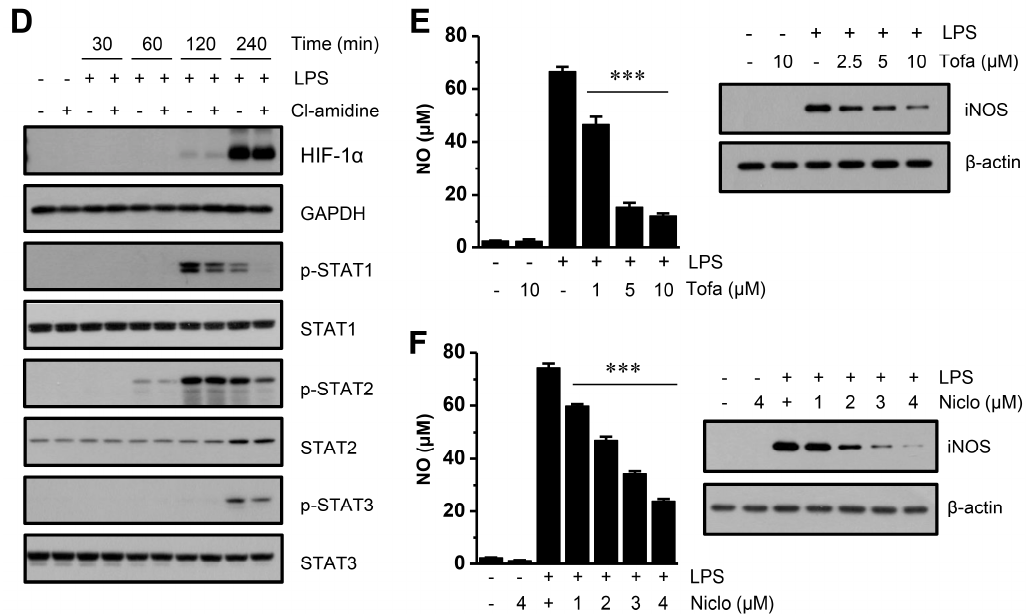
Figure 4. Cl-amidine does not affect MAPK/NF- κ B signaling but attenuates STAT activation. ( A ) After pretreatment with SB203580 (20 µ M; p38 inhibitor), U0126 (20 µ M; ERK inhibitor), SP600125 (20 µ M; JNK inhibitor), BAY 11-7085 (20 µ M; NF- κ B and I κ B α inhibitor), or PI-103 (5 µ M; PI3K inhibitor) for 2 h, DCs (5 × 10 5 cells) were incubated with LPS for 24 h. NO was measured by ELISA at 540 nm (mean ± SD; n = 3). *** p < 0.001. ( B – D ) In the absence or presence of Cl-amidine (200 µ M), DCs (4 × 10 6 –8 × 10 6 cells) were incubated with LPS (0.1 µ g/mL) for the indicated lengths of time. Expression levels of phosphorylated (p-) p38, ERK, JNK, p65 ( B ), HIF-1 α , STAT1, and STAT3 ( D ) were probed by Western blotting with appropriate antibodies. β -actin and GAPDH were used as the loading controls. ( C ) After DCs were activated with LPS for 1 h, DNA binding activity of NF- κ B p65 was measured by ELISA as described in the Materials and Methods. ( E , F ) After pretreatment with tofacitinib ( E : Tofa; JAK inhibitor) or niclosamide ( F : Niclo; STAT inhibitor) for 1.5 h, NO production and iNOS expression were measured by ELISA ( left panel) and Western blotting ( right panel). *** p < 0.001.